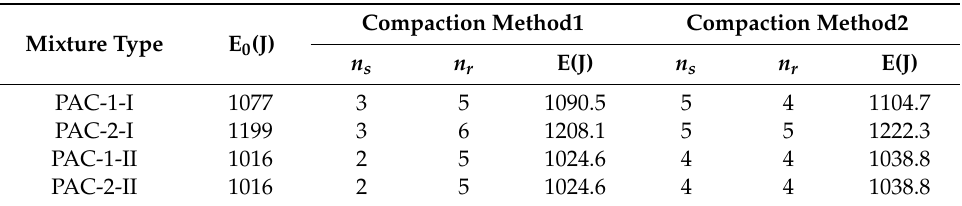
Table 7. Compaction method for four asphalt